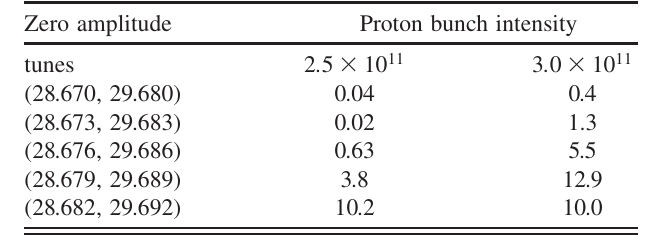
TABLE IV. Proton beam loss rates (in units of %/hour) of